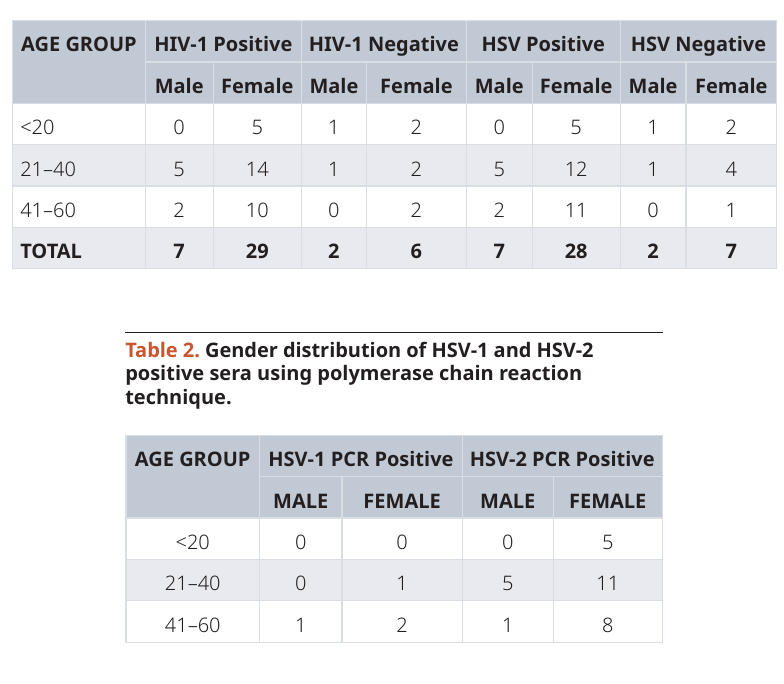
Table 1. Demographics and ELISA screening of HSV IgG and HIV-1 p24 with a reflection of the demographics of the samples used in the study.